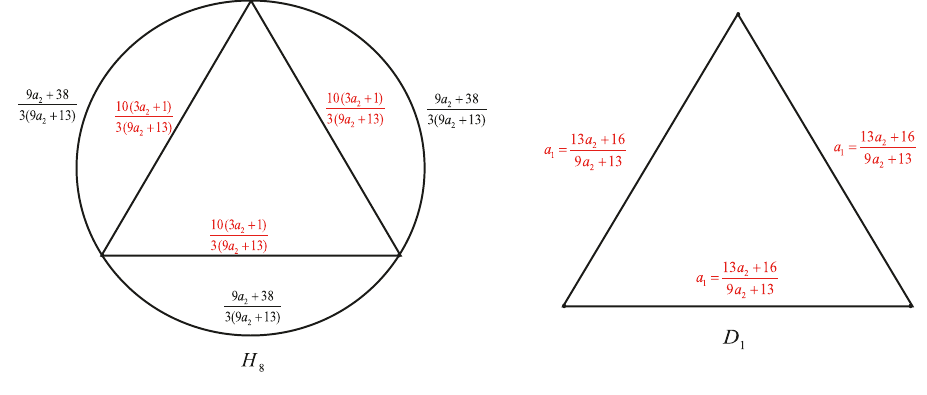
Figure 8: The transformations from 𝐷 2 to 𝐷 1 .